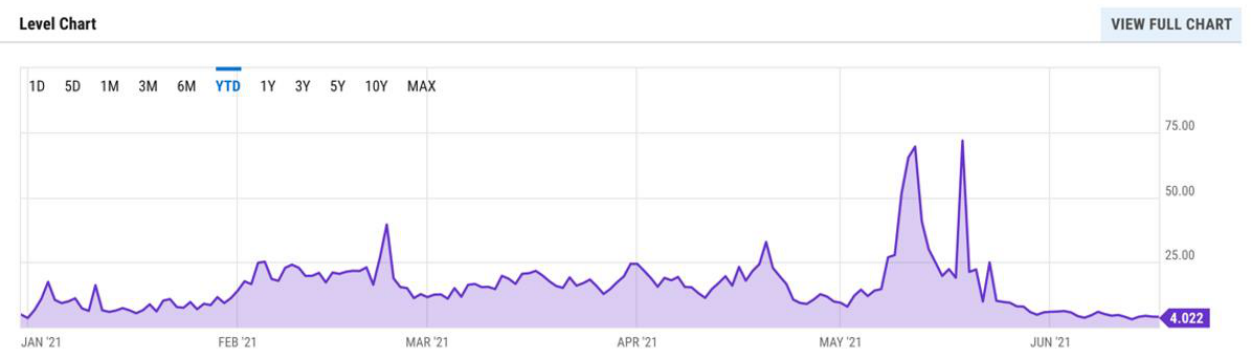
Figure 1. Ethereum average transaction fee in USD (YTD).